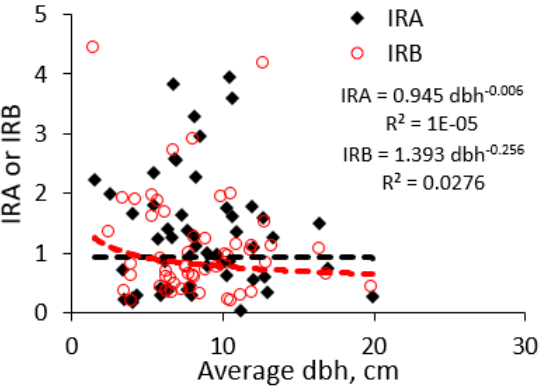
Figure 9. Relationship between average value of the IRA and IRB indices and average stem diameter at which a tree species was observed for the 50+ tree species in the survey.